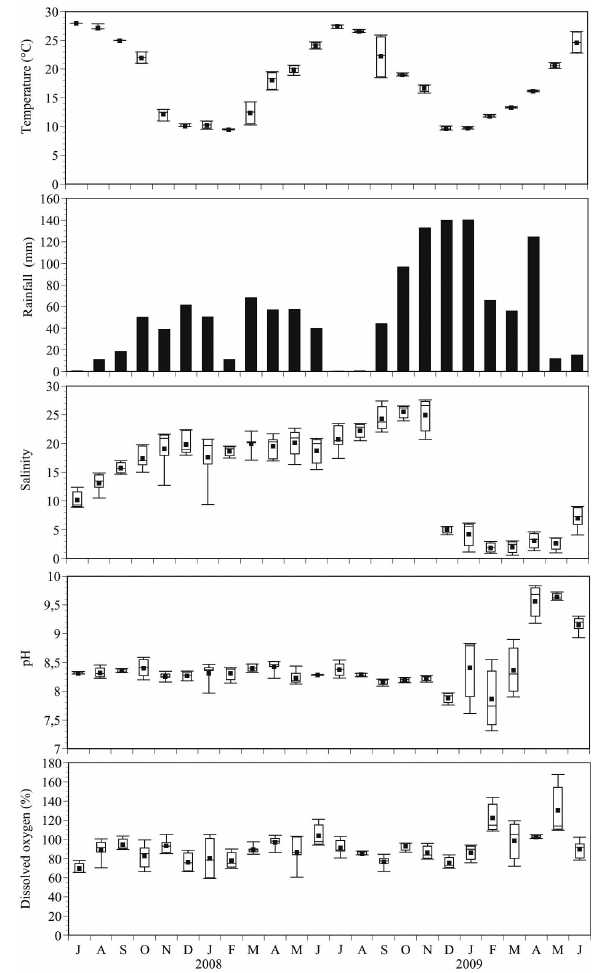
Fig . 2. – Seasonal variations in the main environmental parameters in Cabras Lagoon during the investigation period. The whiskers extend from the 10th percentile to the 90th